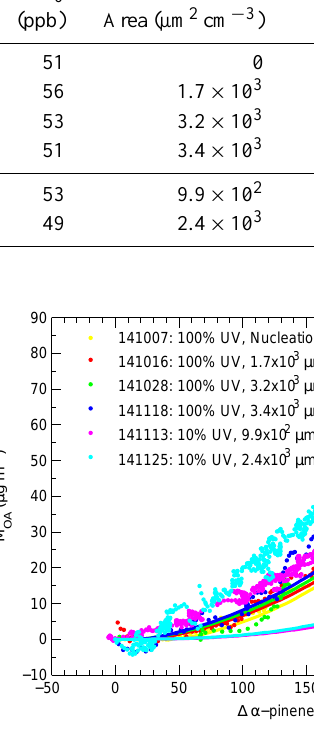
Table 1. Initial conditions for photooxidation experiments. Expt.